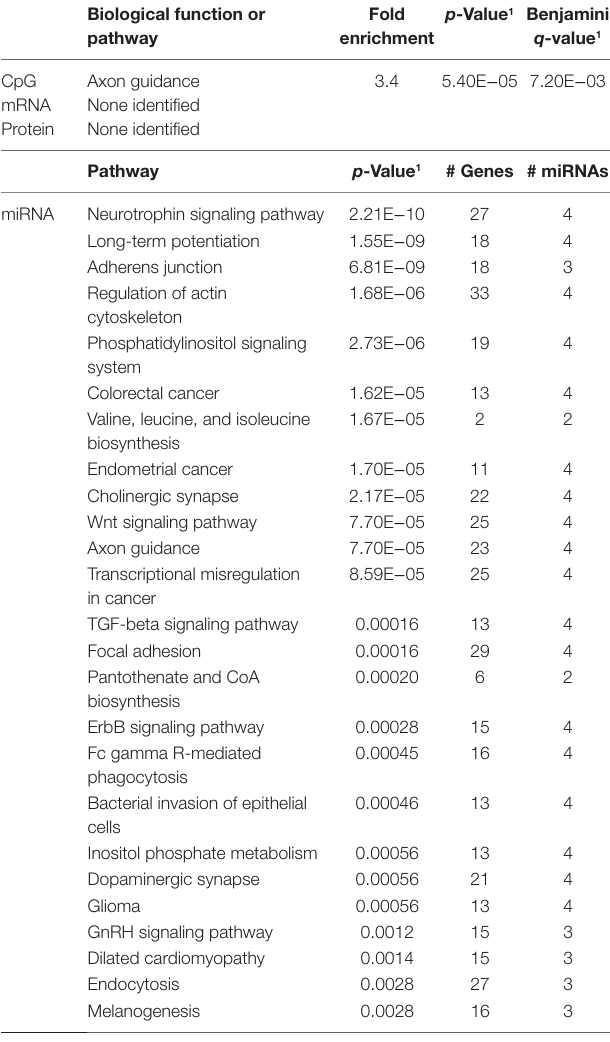
TaBle 7 | Biological functions correlated with cD4 + /cD8 + T cell ratio. Biological function or